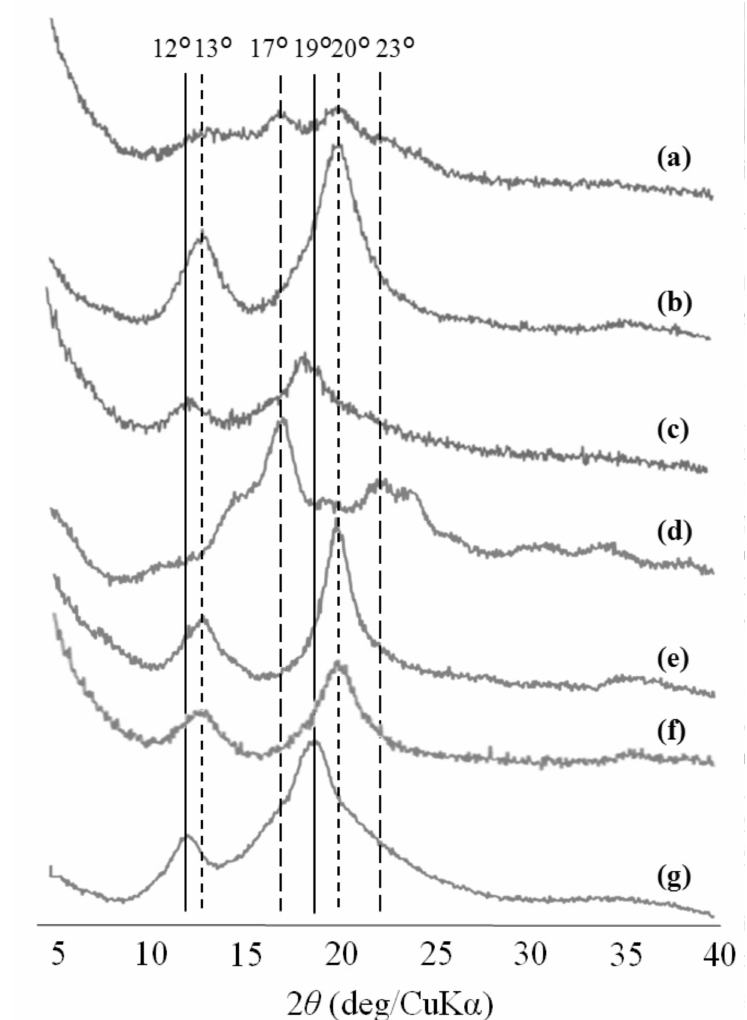
Figure 2. X-ray diffraction (XRD) profiles of lyophilized samples from PTHF ( a ), PCL ( b ), and PLLA ( c ), enzymatically synthesized amylose ( d ), amylose-PTHF inclusion complex ( e ), amylose-PCL inclusion complex ( f ), and amylose-PLLA inclusion complex ( g